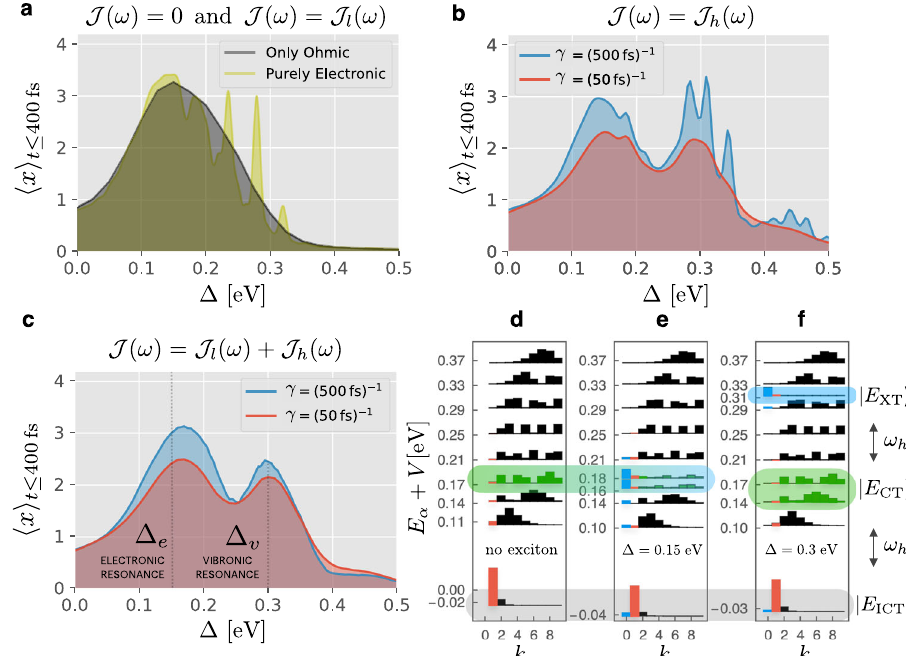
Fig. 2 Charge separation under different vibrational environments and electronic eigenstate structures. a Time-averaged mean electron – hole distance 〈 x 〉 t ≤ Δ when vibrational environments are absent ( J ð ω Þ ¼ 0) or only low-frequency phonon baths are 400fs is displayed as a function of driving force present ( J ð ω Þ ¼ J l ð ω Þ ), shown in yellow and gray, respectively. Here we consider a linear chain consisting of a donor and nine acceptors ( N = 10 sites). b , c Time-averaged mean electron – hole distance when electronic states are coupled to b high-frequency vibrational modes only ( J ð ω Þ ¼ J h ð ω Þ ) or to c the total vibrational environments ( J ð ω Þ ¼ J l ð ω Þ þ J h ð ω Þ ). Here the vibrational damping rate of the high-frequency modes with frequency ω h = 1200 cm − 1 is